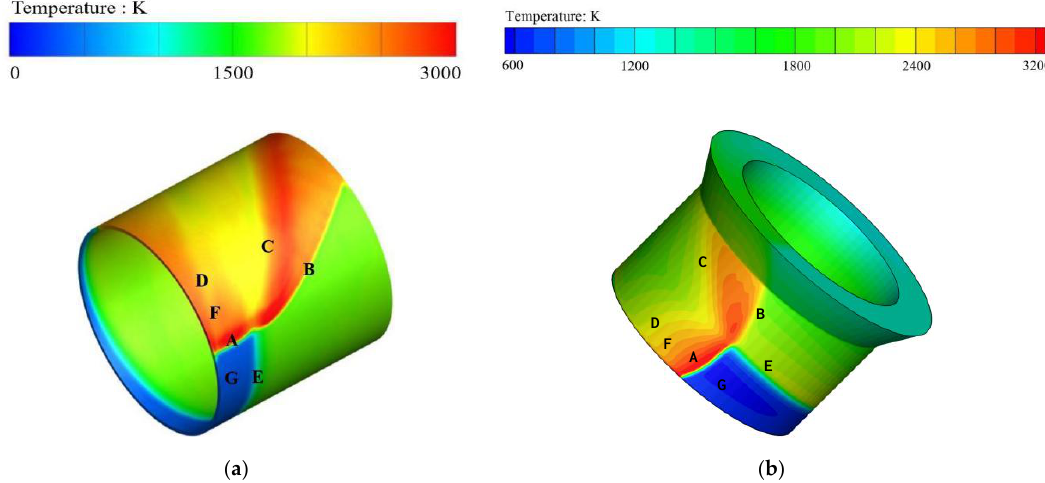
Figure 3. Comparisons of ( a ) the result of Innovative Scientific Solutions Inc. (ISSI) [47] with ( b ) numerical simulation in this study. (A: detonation wave, B: oblique shock wave, C: mixing region, D: expandable region, E: discontinuous region between detonation product and fresh mixture, F: blocking region, G: fresh mixture region).